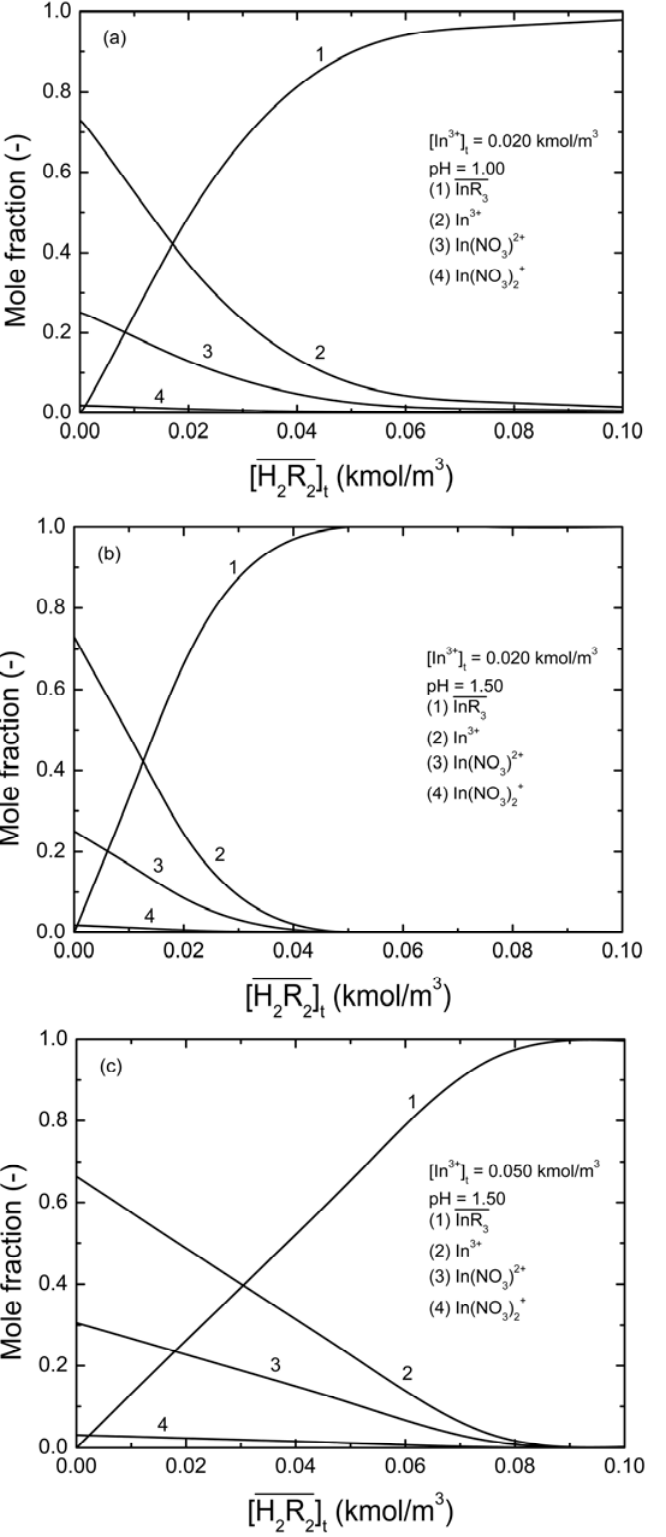
Figure 6. The mole fractions of indium ions and their complexes as a function of the total D2EHPA concentration at two different total concentrations of indium and two pH